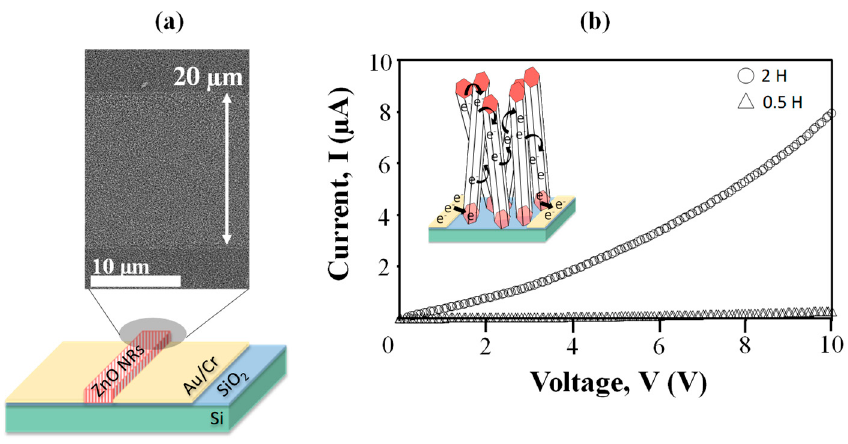
Figure 6. ( a ) Metal-semiconductor-metal structure used to measure electrical properties of the ZnO NRs, with its morphological FESEM image. ( b ) I–V curve of the ZnO NRs at different immersion time of 0.5 h and 2 h. Inset shows an illustration of electron movement in ZnO NRs.